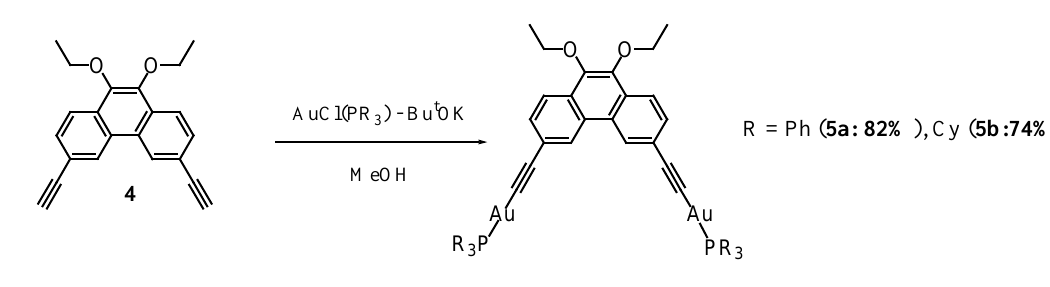
Scheme 2. Synthesis of complexes 5a and 5b.